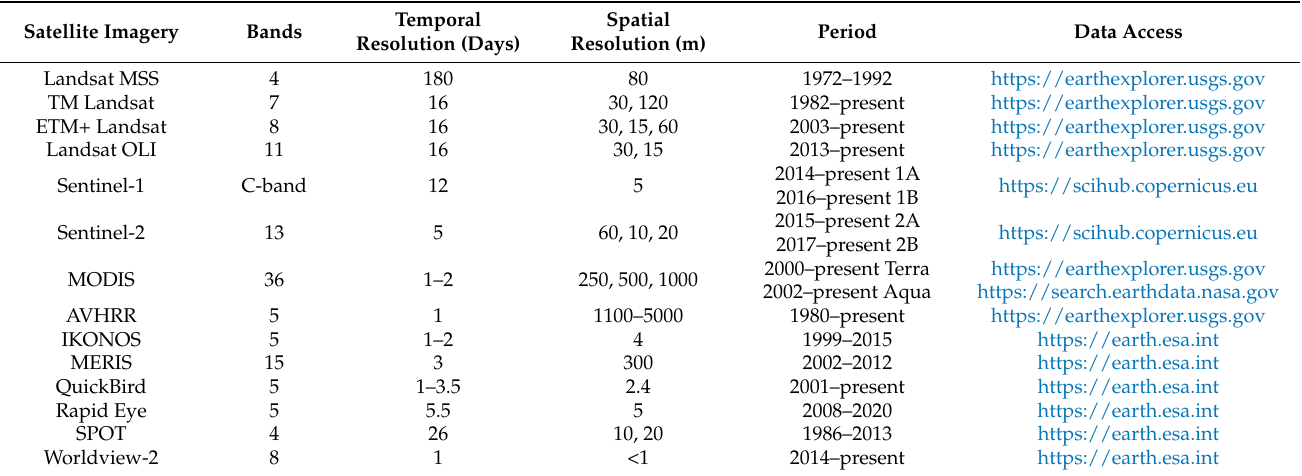
Table 3. Commonly used multispectral satellite